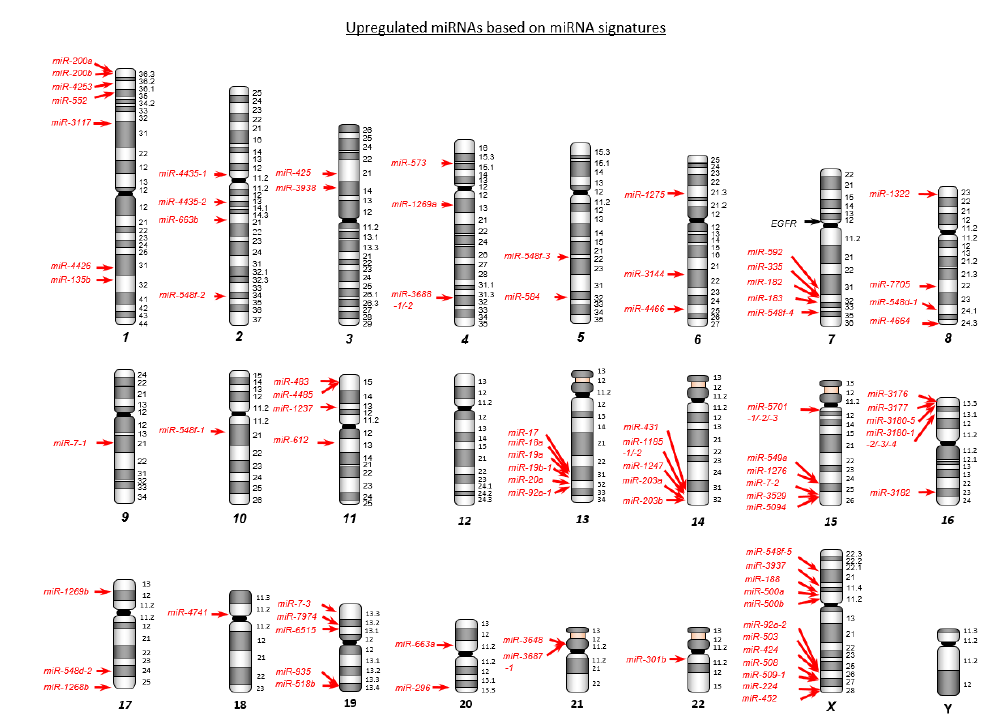
Figure 1. Chromosome mapping of aberrantly upregulated miRNAs in colorectal cancer (CRC). Upregulated miRNAs in CRC tissues are mapped on human chromosomes. A total of 84 miRNAs are identified by our RNA sequence based signature.